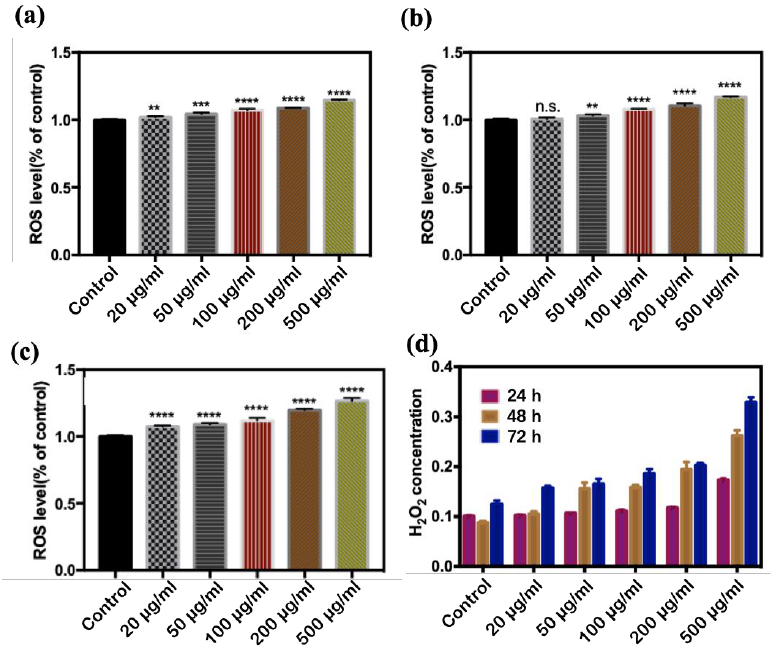
Figure 4. Concentrations of MDA and H 2 O 2 produced by E. coli exposed to different concentrations of CQDs. ( a ) MDA24 h, ( b ) MDA48 h, and ( c ) MDA72 h, ( d ) HRP test (n.s. p > 0.05, ** p < 0.01, *** p < 0.001, and **** p < 0.0001).